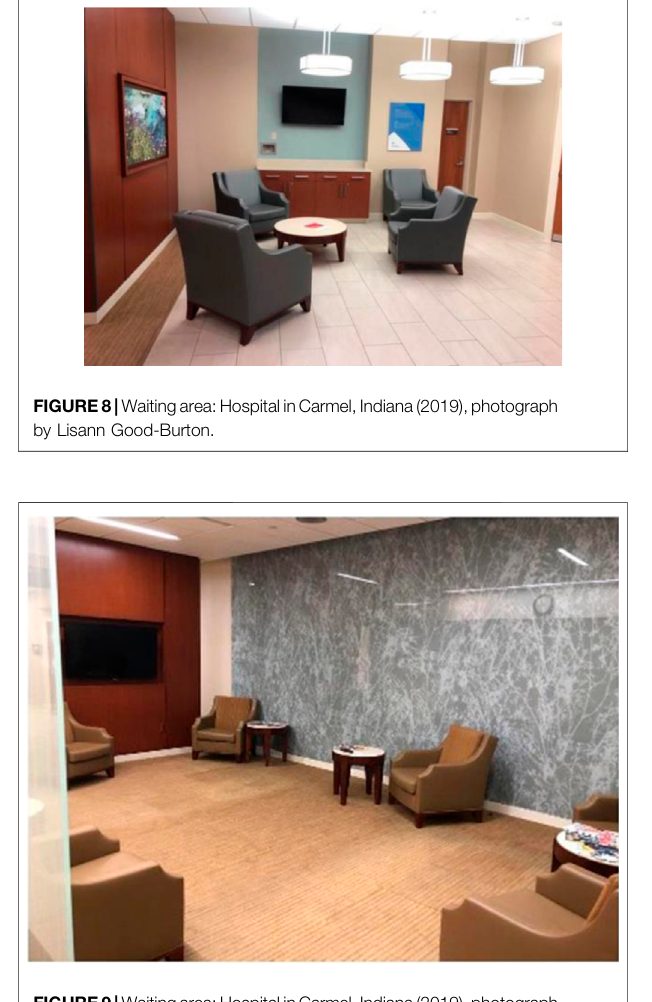
Frontiers in Communication |